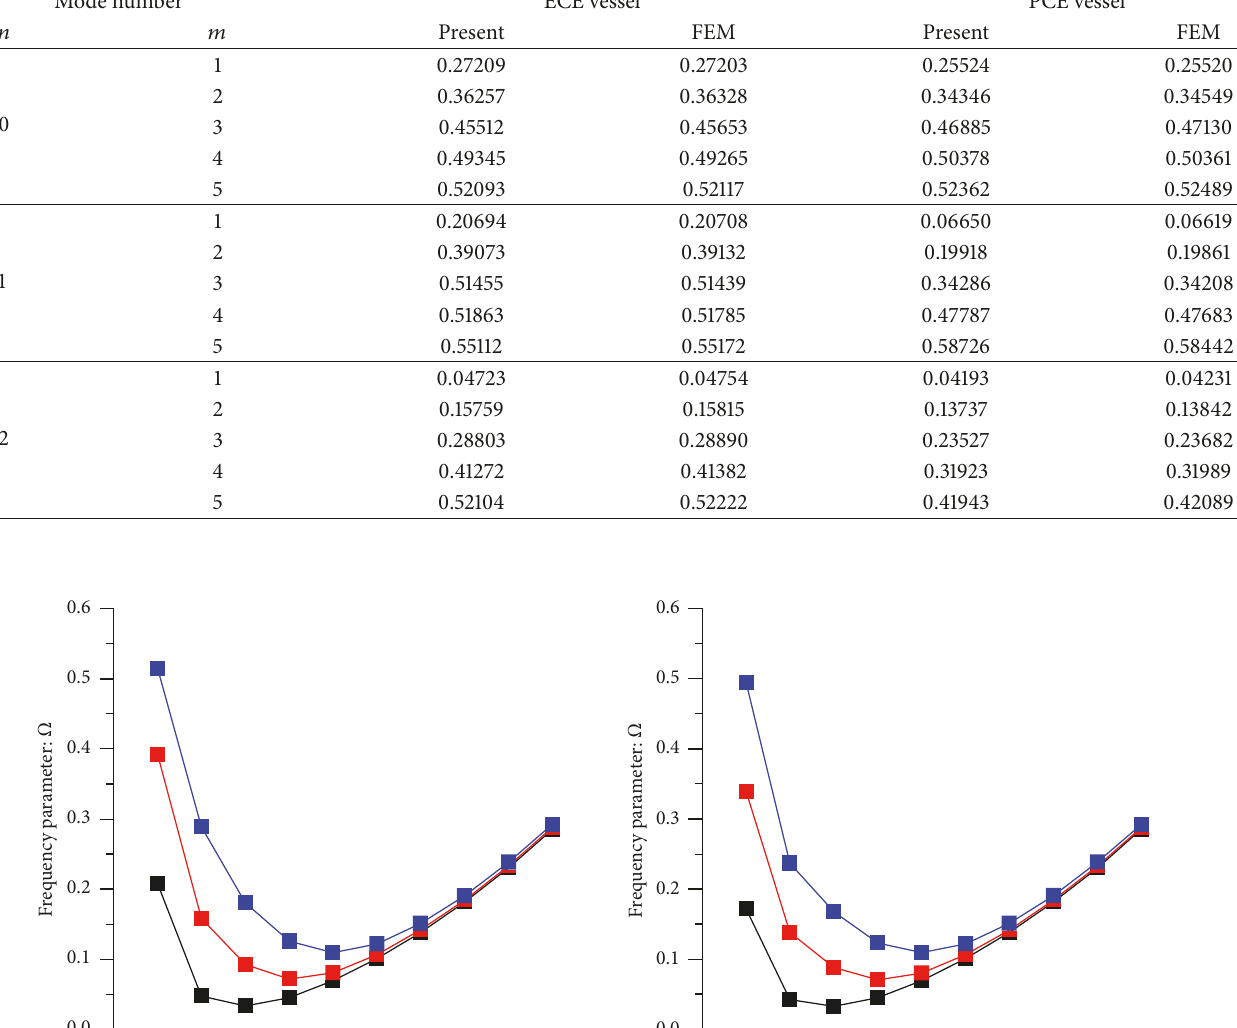
Table 2: Comparison of some frequency parameters Ω = 𝜔𝑅 𝑐 √𝜌(1 − ] ) 2 /𝐸 for the ECE vessel and PCE vessel ( 𝑁 𝑙 = 4 , 𝑁 𝑐 = 8 , 𝑁 𝑟 = 4 , 𝛼 = −0.5 , and 𝛽 = −0.5 ).